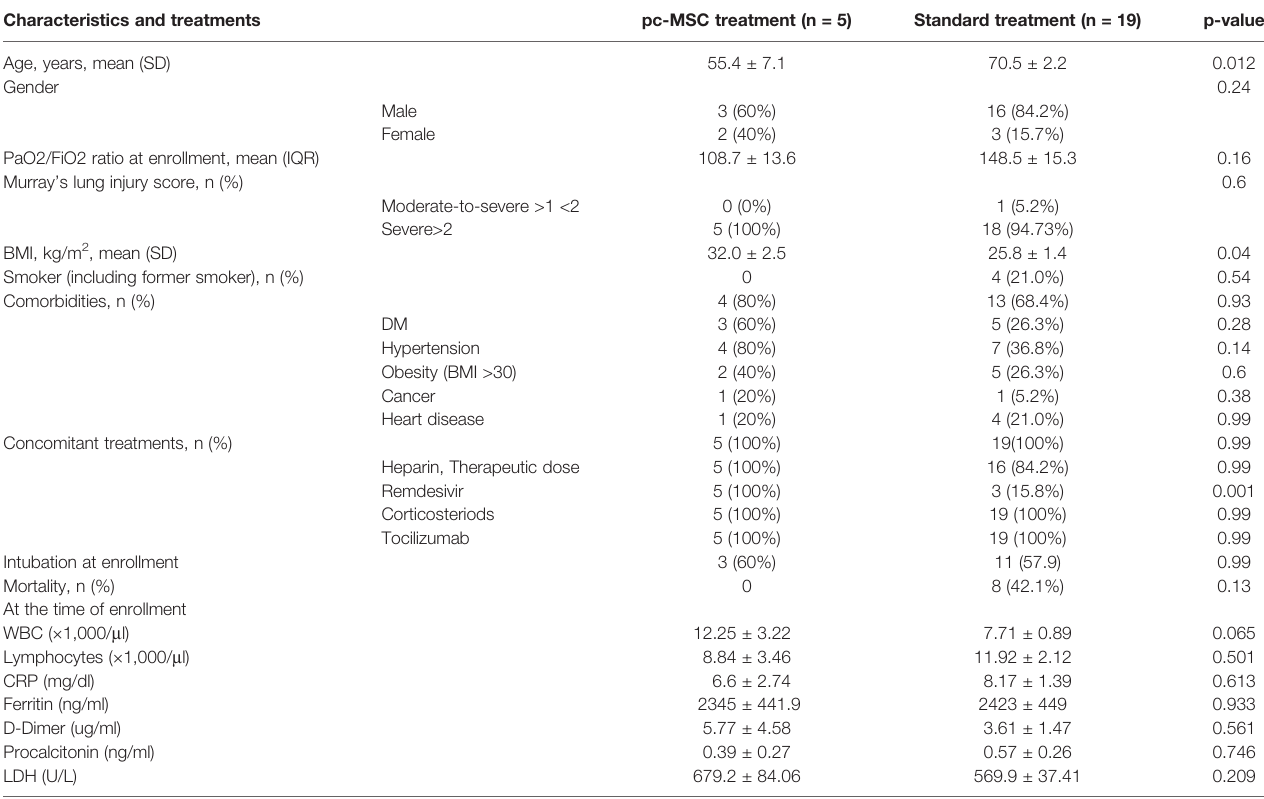
TABLE 2 | Demographics and baseline characteristics of the pc-MSC treated and standard treatment group with serum in fl ammatory markers and clinical outcome. Characteristics and treatments